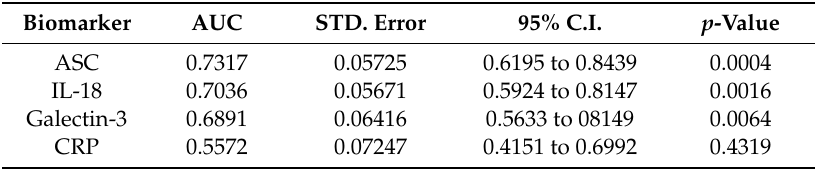
Table 1. ROC analysis results for signaling proteins in serum.